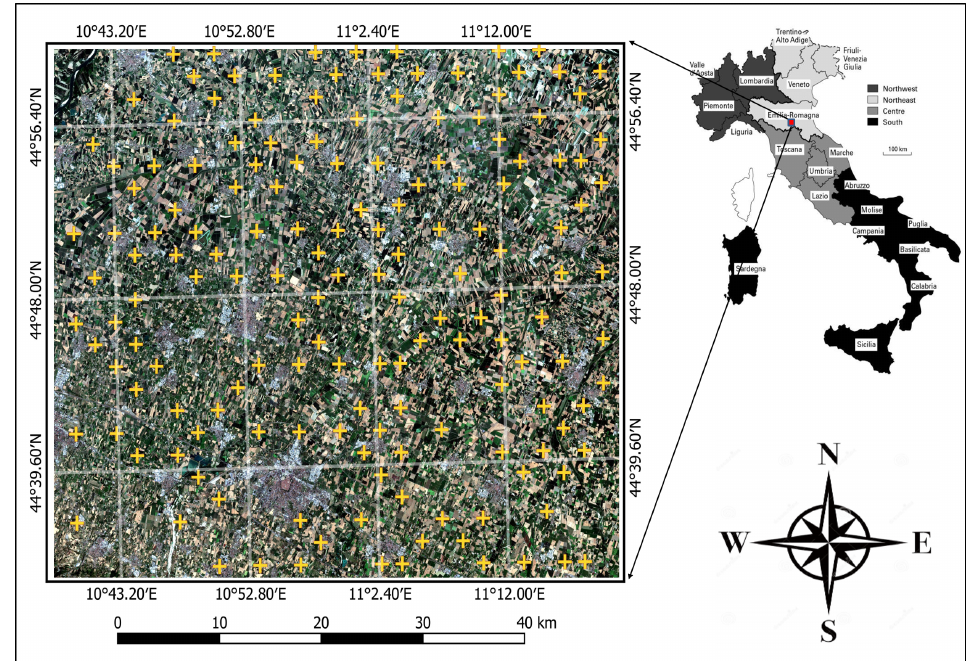
Figure 1. The study site is located in Carpi, region Emilia-Romagna is shown with the geo-coordinates (WGS84). RGB image composite derived from sentinel-2 imagery acquired in August-2015 is shown and the yellow marker showing geo-locations of ground truth land cover extracted from the Land Use and Coverage Area frame Survey (LUCAS-2015).